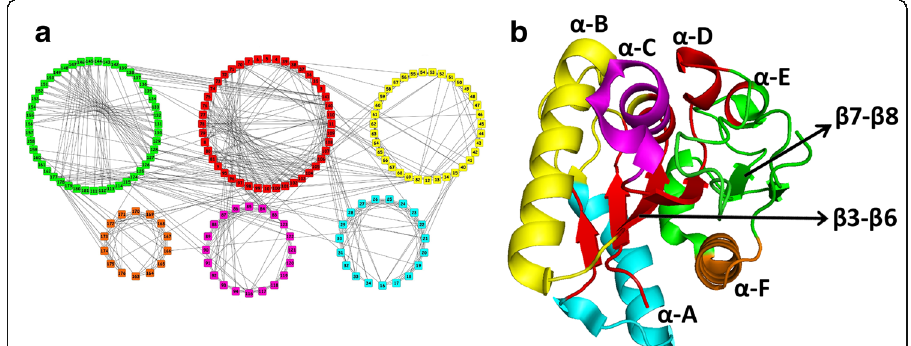
Fig. 6 Community structure analysis of the wild-type (WT) PCN. ( a ) Six major communities in WT; ( b ) Three-dimensional structure of the WT Lipase A. Colour code in B corresponds to the communities in the WT are: Red (having the central β -sheet: β 3, β 4, β 5, β 6; helix α -D and part of helix α - E); Green (the largest module with portions of helices α -E and α -F, strands β 7 and β 8, and major loop region); Yellow (the helix α -B, a small portion of helices α -C and terminal α -A); Cyan (a major portion of helix α -A); Magenta (lower portion of the helix α -C), and the smallest community Orange (portion of α -F). In the rest of the community structure analysis for the mutant PCNs, these colours of the member nodes have been kept the same for easy identification of their reorganization. The loop regions where many